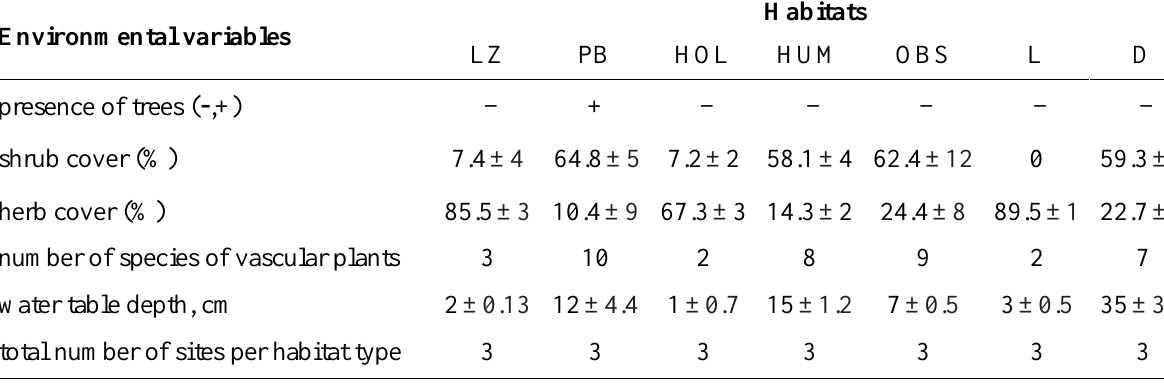
Figure 3. Locations of the sampling sites on the peat bog Yelnia, superposed on the 3-D landforms model from Grumo et al . (2010). Habitat symbols: lagg zone (LZ); pine bog (PB); hollow (HOL); hummock (HUM); open bog space (OBS), lakeshore (L); dome (D). Table 1. Site characteristics shown as means (± SE) of the vegetation structure and water